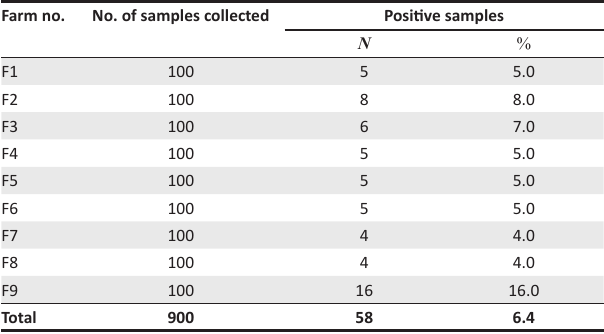
TABLE 2: Number of samples collected and Salmonella isolation rate per farm. Farm